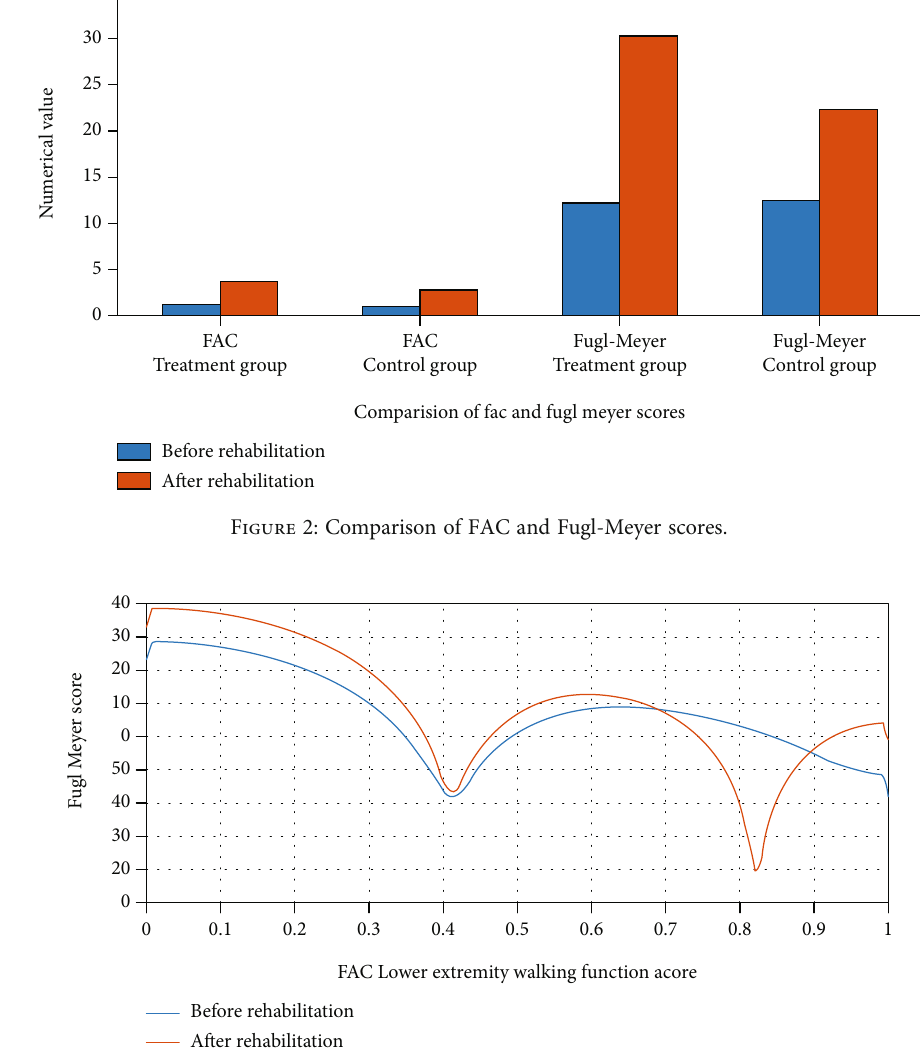
Figure 3: Comparative analysis of FAC and Fugl-Meyer before and after rehabilitation. Table 5: NIHSS scores of the two groups before and after treatment.